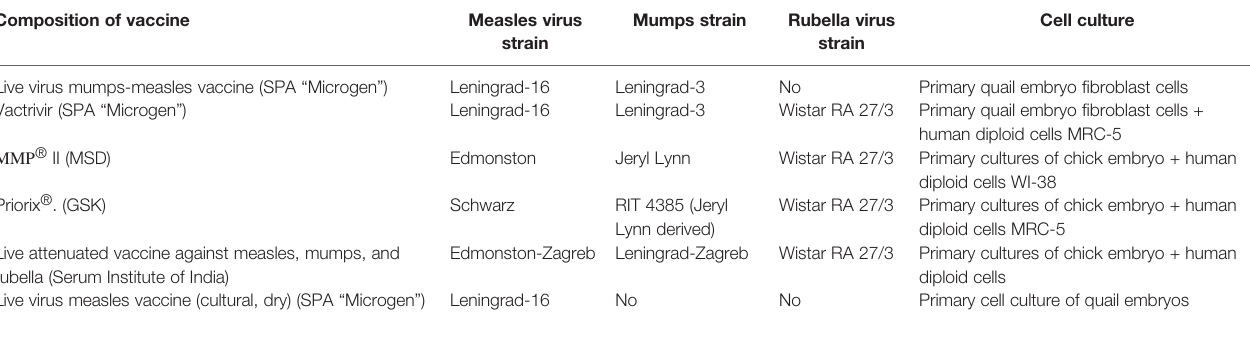
TABLE 3 | Characteristics of the vaccine preparations registered in the Russian Federation for active immunization against measles. Composition of